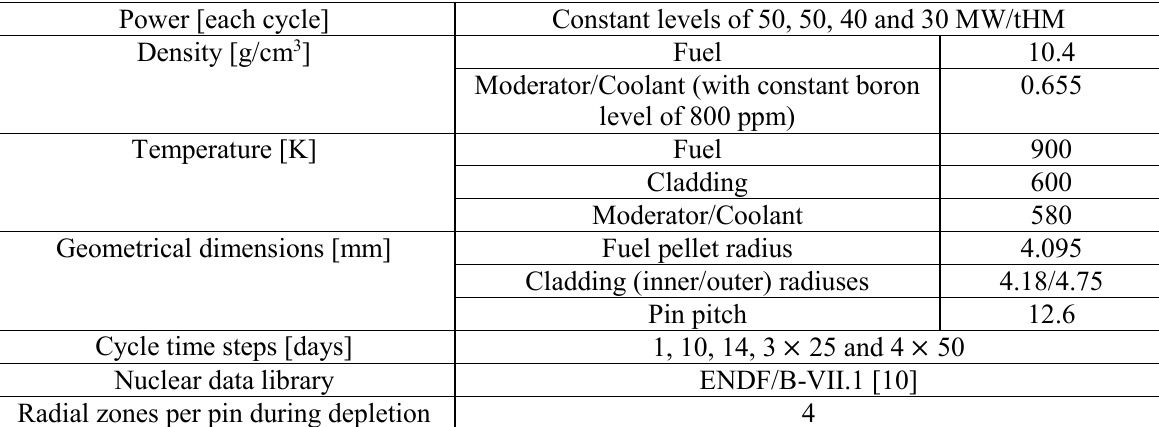
Table I. Model characteristics in